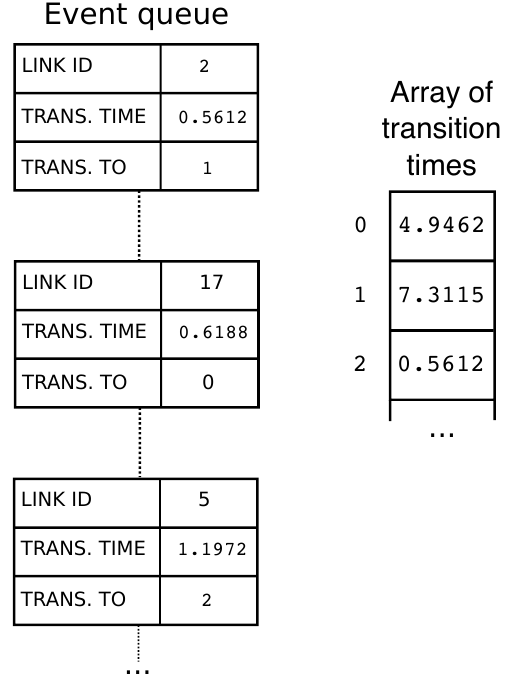
Figure 6. Illustration of the event queue and the transition-time ar- ray ( next_update ). Each event object contains the ID number of the link, the time at which the next transition is scheduled to oc- cur, and the link-state code for the transition (that is, the code for the new cell pair after transition occurs). Left: events are stored in a heap that is sorted by transition time, soonest on top. Right: the transition-time array, which is simply an ordered array, indexed by link ID, containing the time of the next scheduled transition at the corresponding link. If the transition time for an event object does not match the corresponding entry in the transition-time array, it means that the originally scheduled transition has been nullified by other transitions and is no longer valid (see